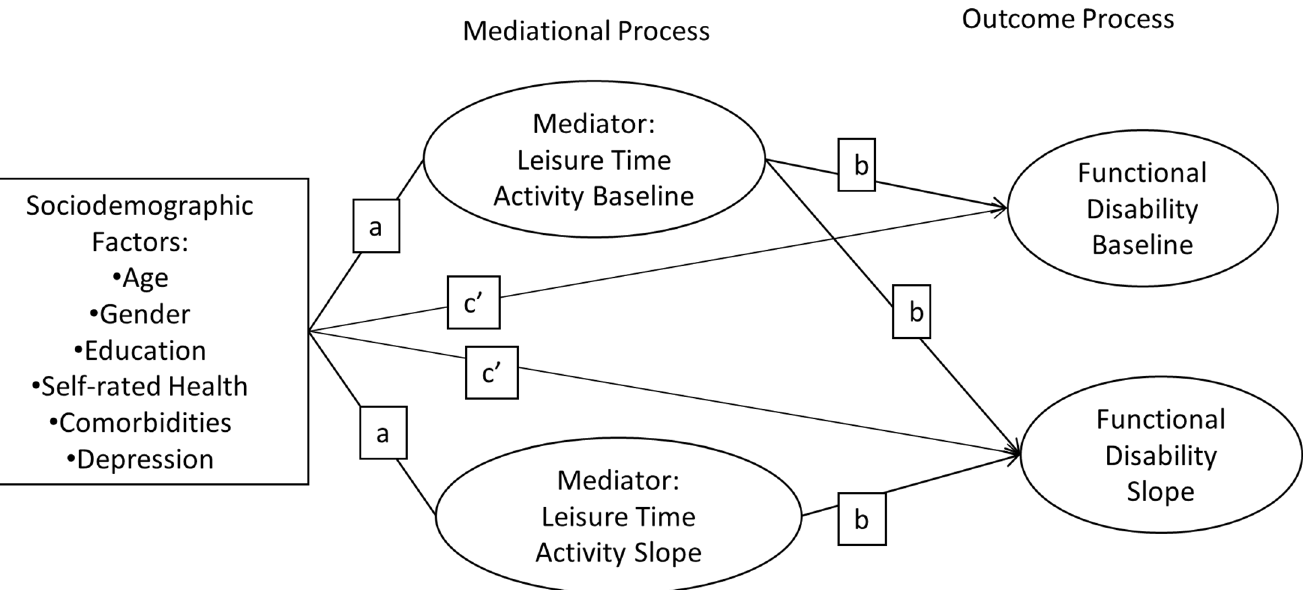
PLOS ONE | https://doi.org/10.1371/journal.pone.0203757 October 3,